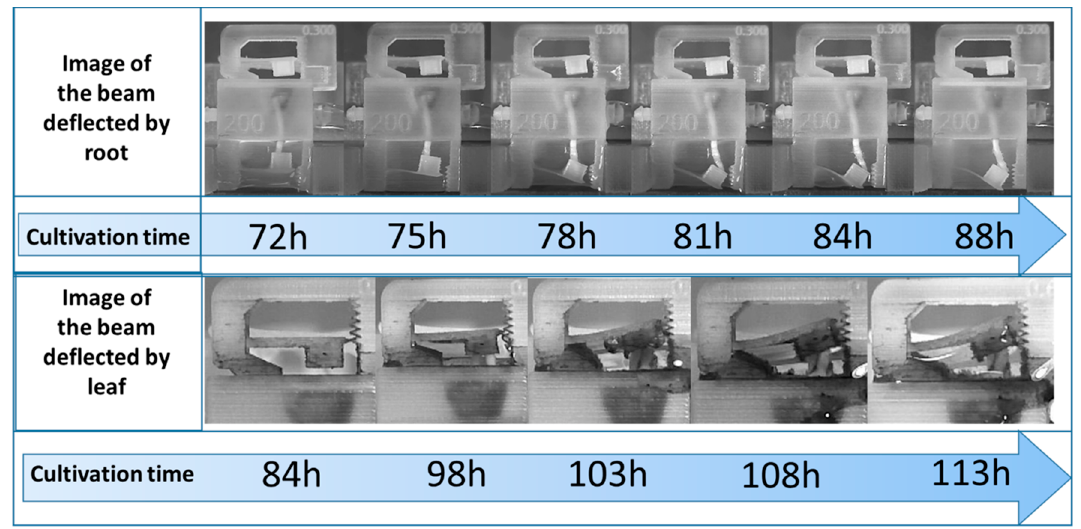
Figure 3. Example image of growing stalk (upper part) and leaf (lower part) utilized for image analyze of growing seed.